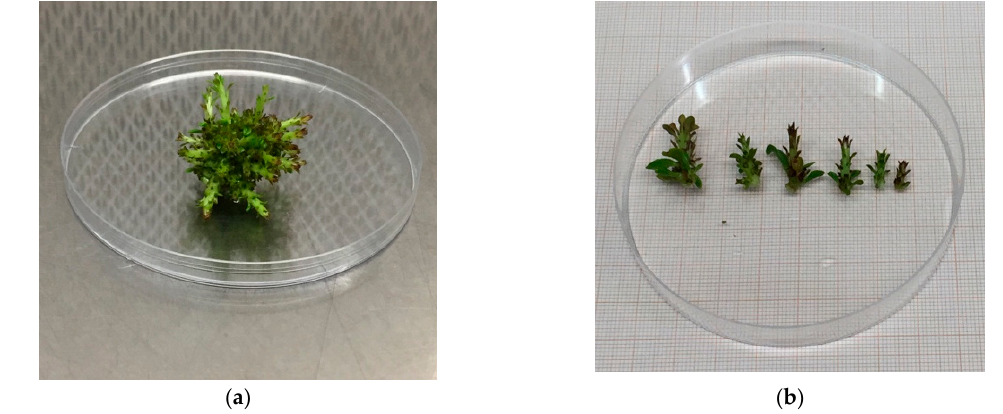
Figure 8. “Sal 39” explant obtained in a bioreactor after 60 days ( a ) and detail of the length of each shoot ( b ).